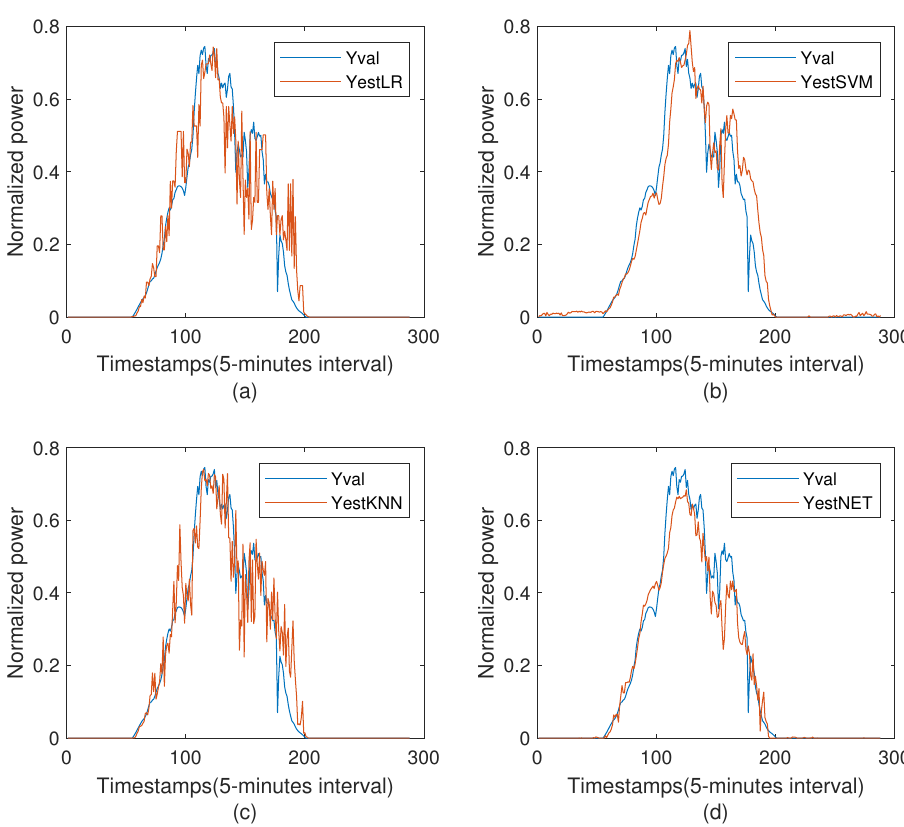
Figure 9. A one-day graph of actual PV power data (blue) versus the estimation with each one of the techniques (orange): Linear Regression ( a ); Support Vector Machines ( b ); K-Nearest Neighbors ( c ); and Artificial Neural Networks ( d ).